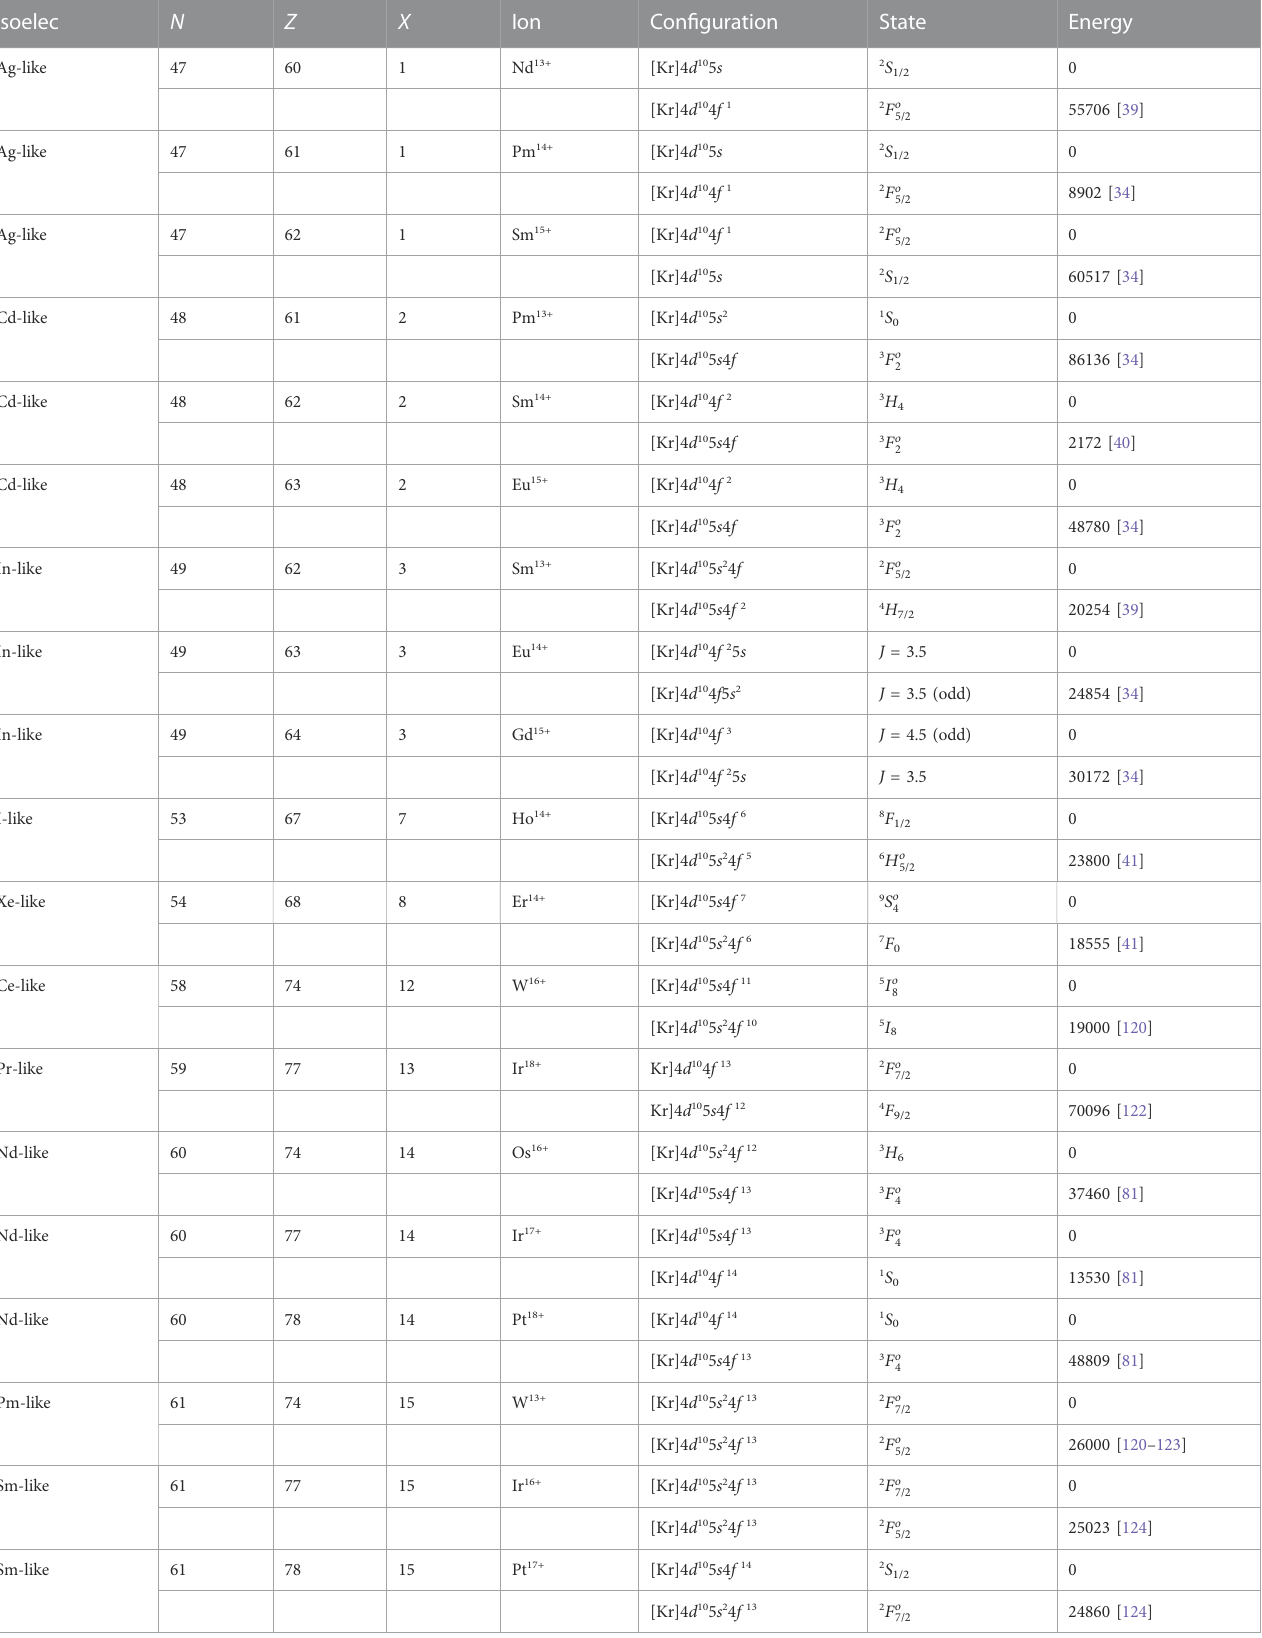
TABLE9TheenergylevelofHCIsintheisoelectronicsequencescontainingthedifferentnumberof5 s and4 f valenceelectrons x ,where N isthenumberoftheelectron, Z is the atomic number. [Kr] ” 1 s 2 2 s 2 2 p 6 3 s 2 3 p 6 3 d 10 4 s 2 4 p 6 . Units for values are in cm − 1